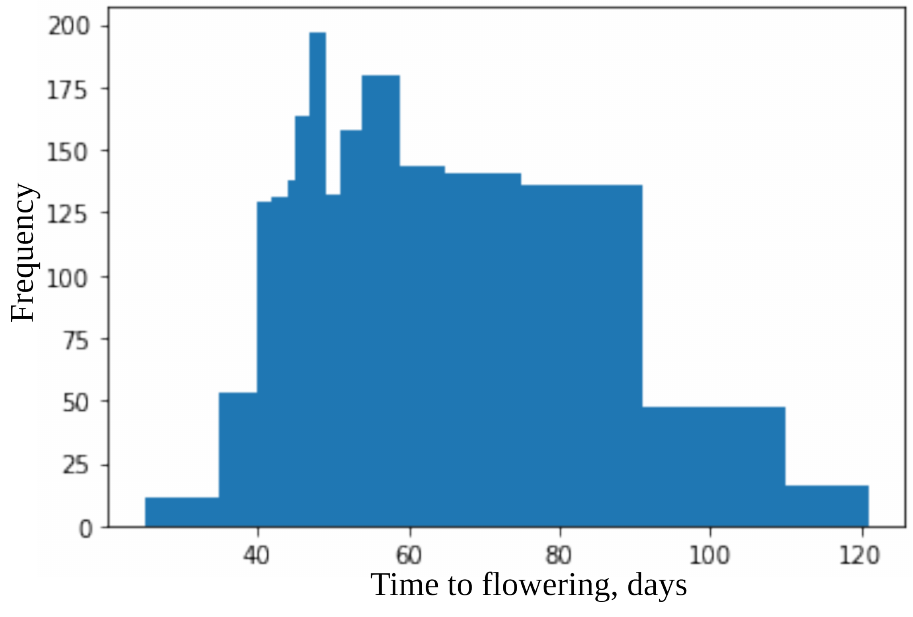
Figure 3. Histogram of time to flowering for dataset.